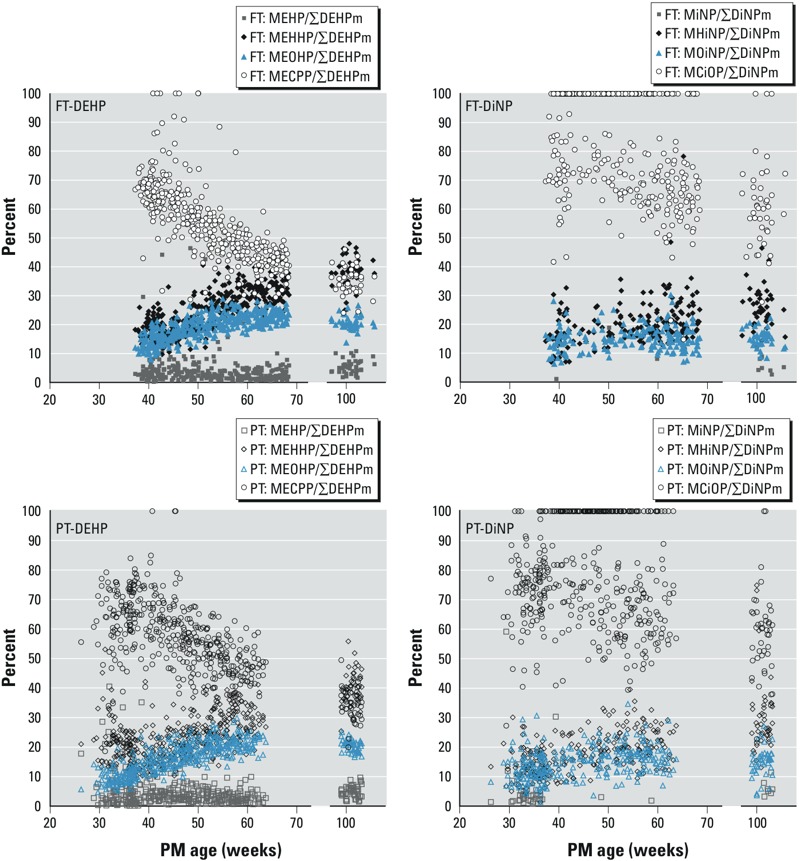
The proportion of individual DEHP or DiNP metabolites versus the total sum of all measured DEHP metabolites (∑DEHPm) or DiNP metabolites (∑DiNPm) by PM age in 58 FT (~ 432 urine samples) and 67 PT infants (~ 462 urine samples). In seven FT and three PT samples, MECPP was the only metabolite of DEHP measured (MECPP/∑DEHPm = 100%), and in 201 FT and 135 PT samples MCiOP was the only metabolite of DiNP (MCiOP/∑DiNPm = 100%) measured.